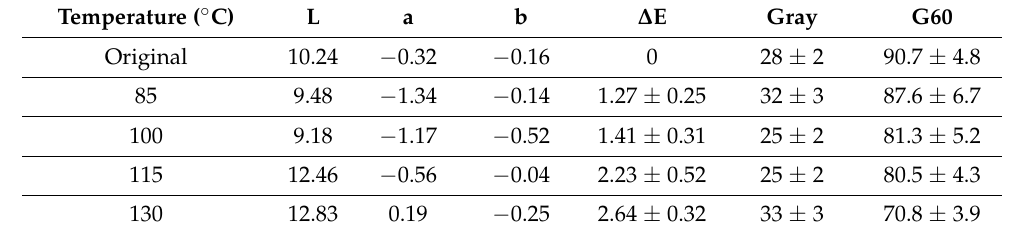
Table 1. Color difference of the aged GF/PEI composites.